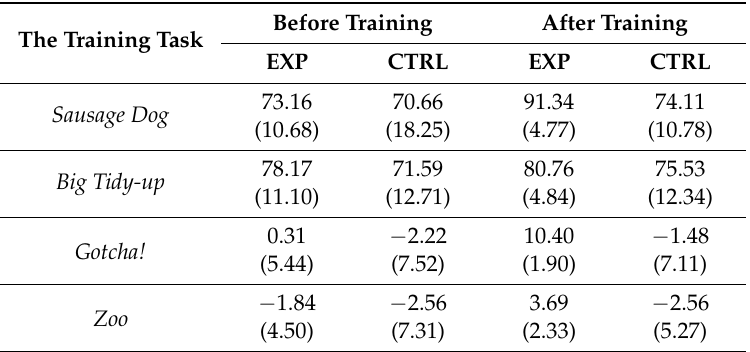
Table 1. Mean raw scores obtained in four training games by two groups (experimental and control) at two testing points (before and after training). Standard deviations are presented in parentheses. Before Training After The Training Task